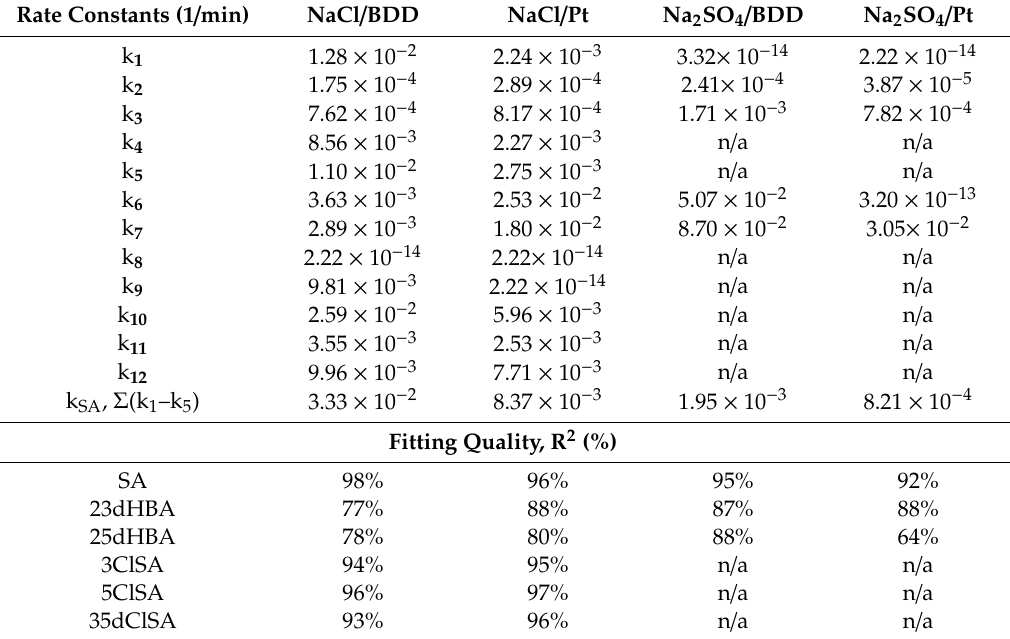
Table 3. Summary rate equations and fitting quality of the kinetic